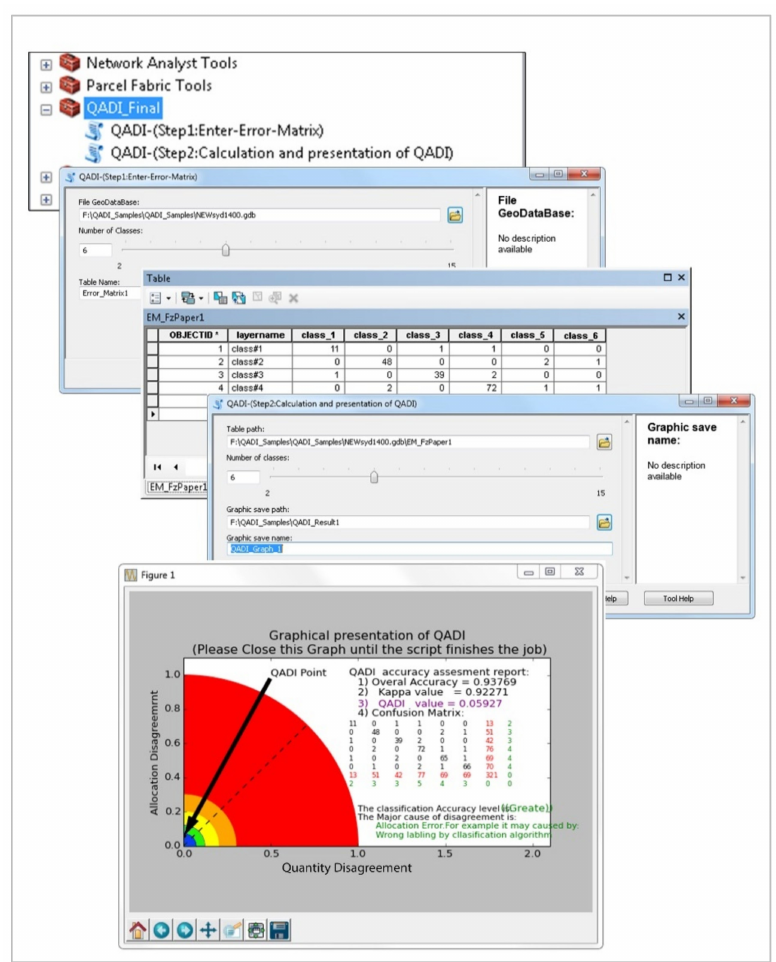
learning (Table 7: [47]), and the three machine learning algorithms random forest, support vector machine, and artificial neural network (Tables 8–10: [48]).